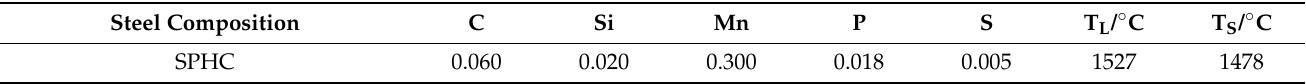
Table 2. Main components, solidus temperature, and liquidus temperature of the steel grade.